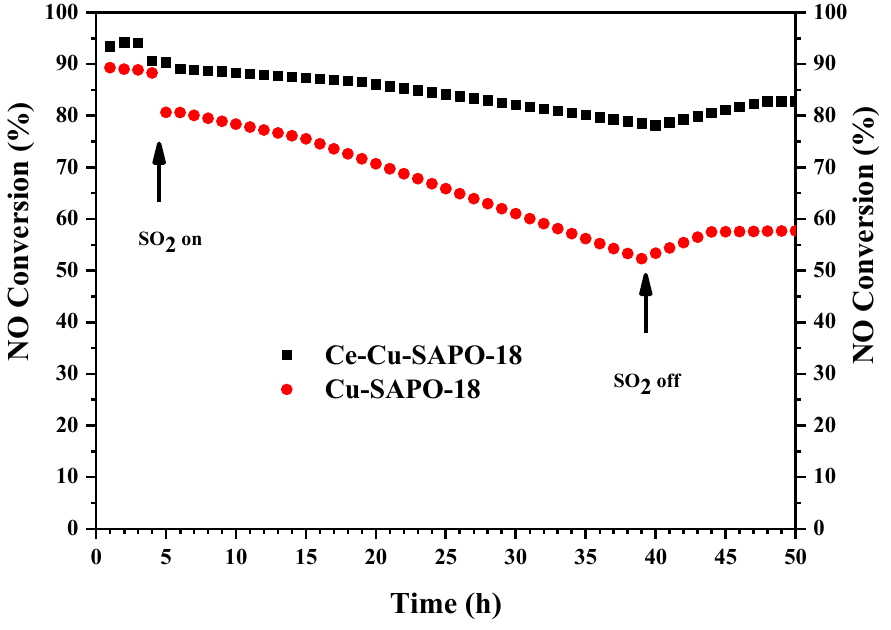
Figure 2. NO conversion as a function of reaction time over the Cu-SAPO-18 and Ce-Cu-SAPO-18 samples in the presence and absence of SO 2 at 300 °C. The reactant feed composition: 500 ppm NO, 500 ppm NH 3 , 100 ppm SO 2 (when used), 14 vol.% O 2 , 5 vol.% H 2 O, and N 2 (balance).